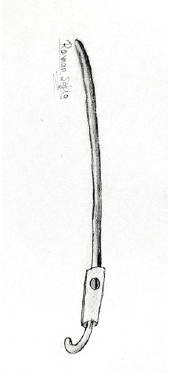
Figure 14. Retrograde Kirschner wire angled hook.